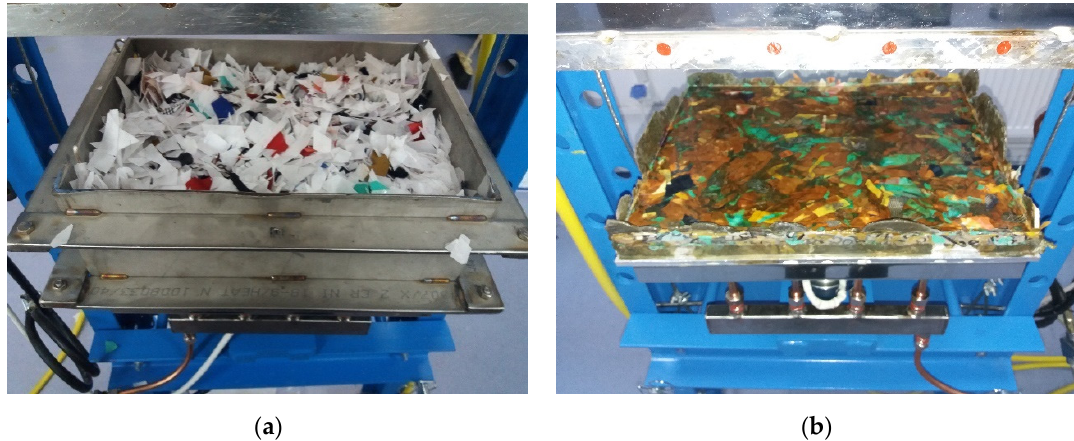
Figure 4. The waste-based composite materials panels: ( a ) pre-and ( b ) post-the technological thermoforming process.